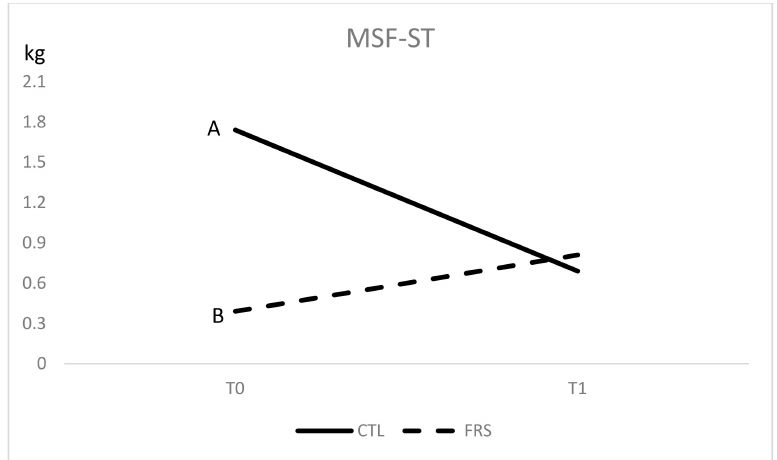
Figure 2. Myofibrillar shear force (MSF) of Semitendinosus muscle (ST). CTL = diet without rye grass; FRS = diet with rye grass; T0 = 5 days of ageing, T1 = 30 days post ageing. A, B = p <